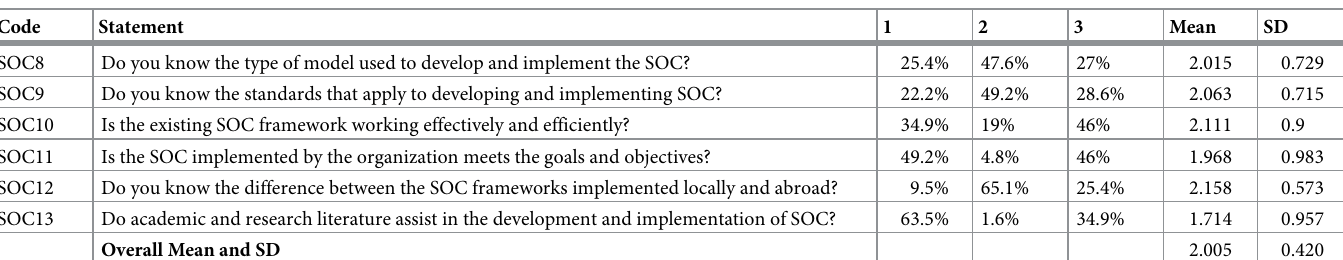
Table 8. Questionnaire on the framework of